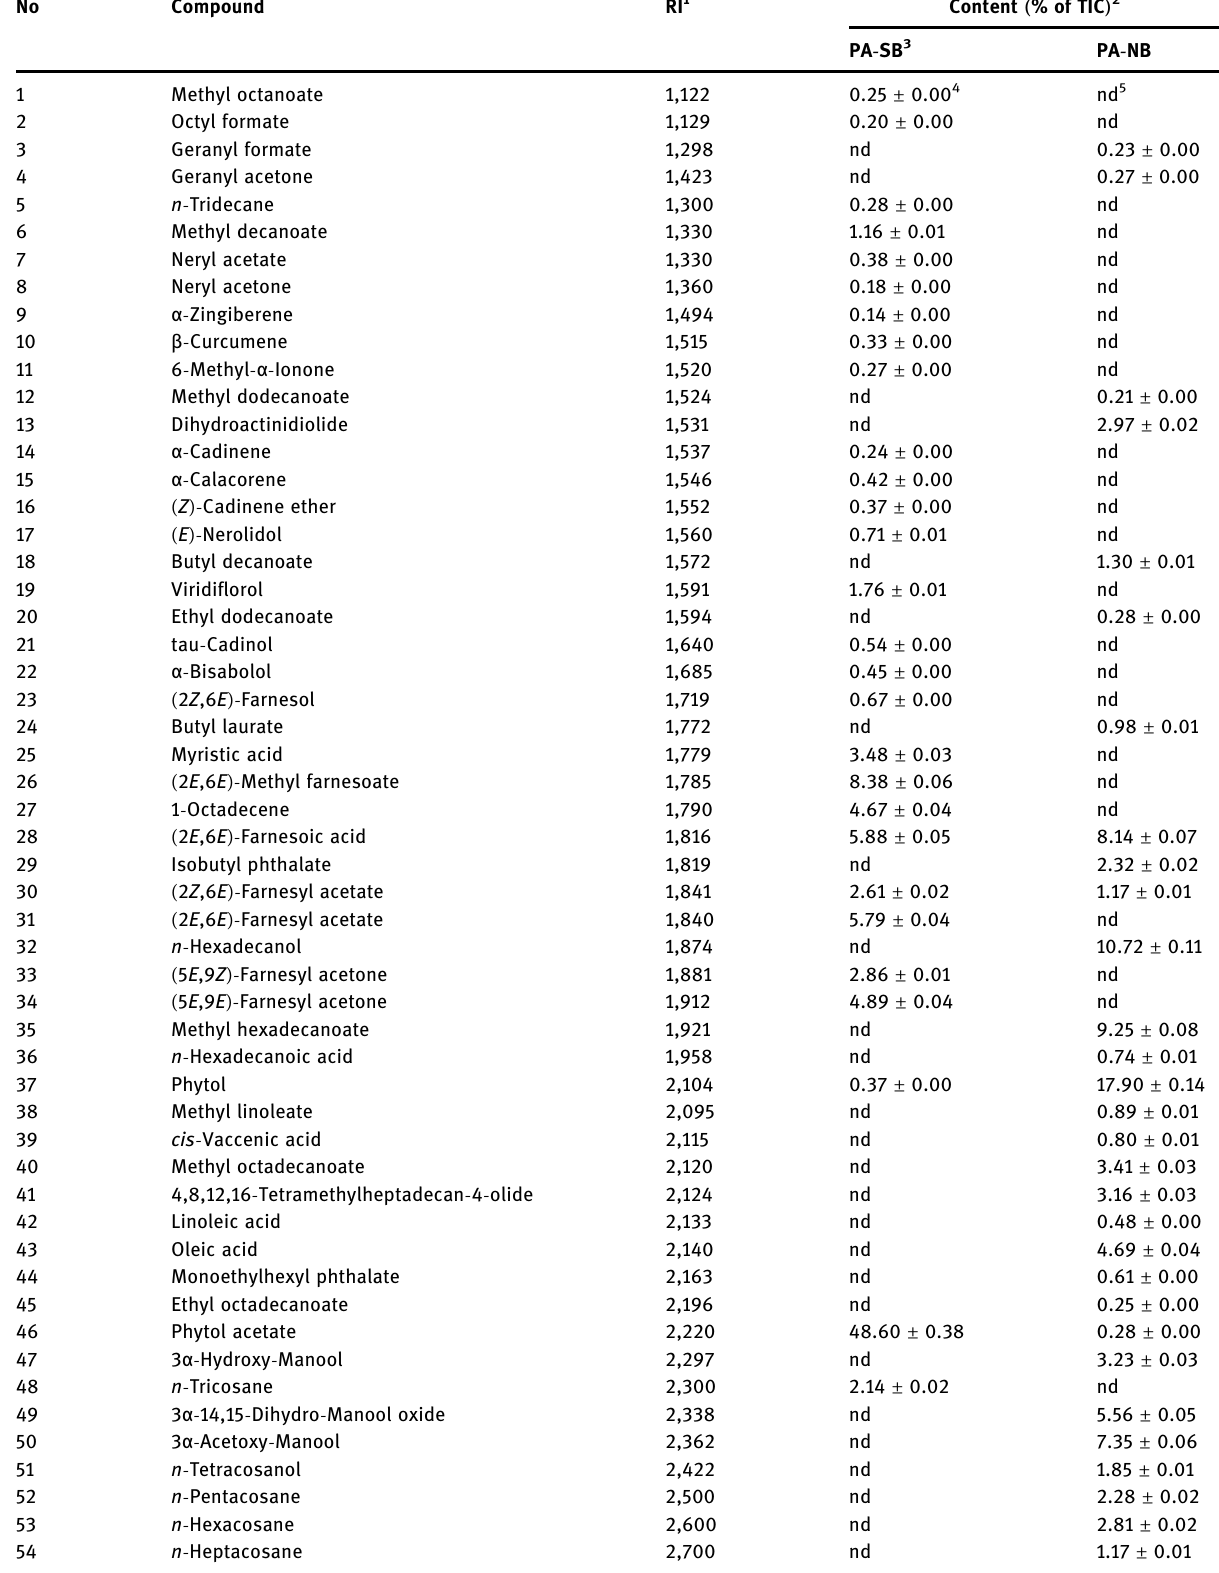
Table 5: Volatile composition ( by GC - MS ) of the obtained P. alkekengi leaf